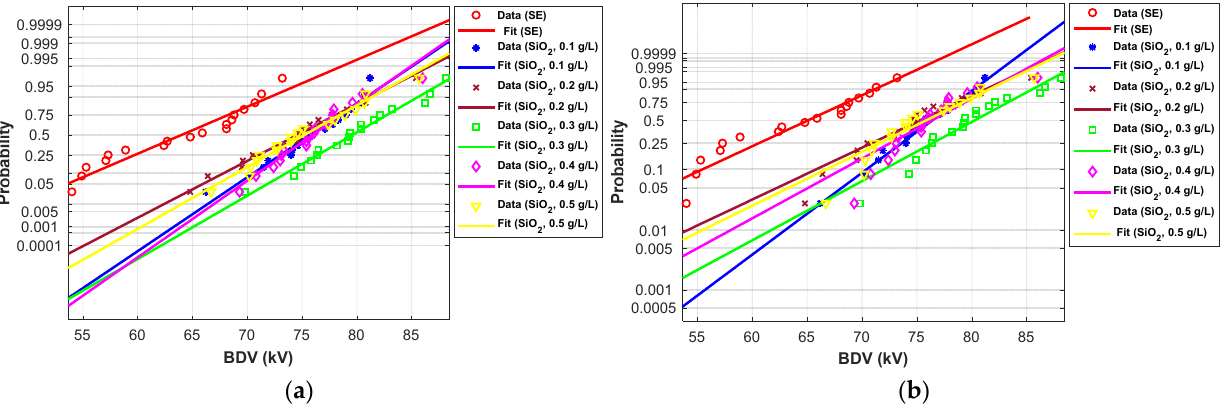
Figure 14. Probability plot of breakdown voltage data of SE-based nanofluids with SiO 2 (10–20 nm) for the 2 mm electrode gap; ( a ) normal and ( b ) extreme value.